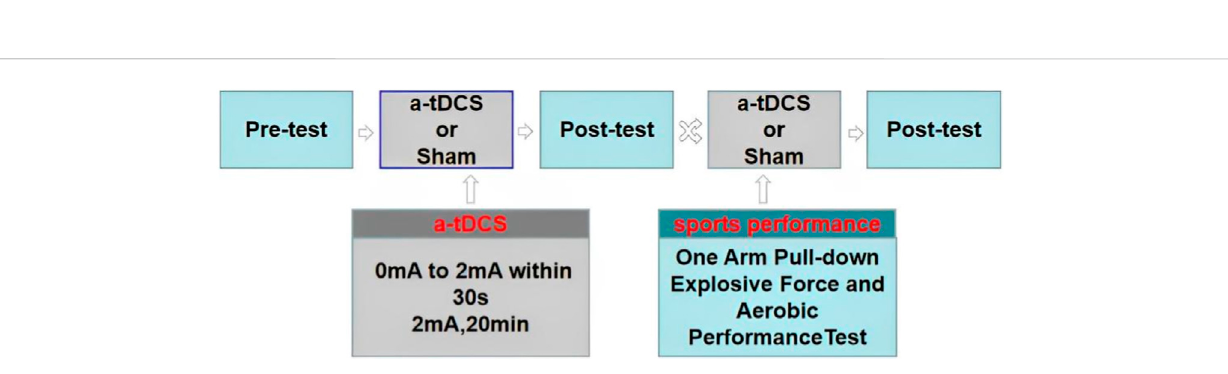
FIGURE 2 Study design. Pre-test and post-test indicate sports performance test, a-tDCS represents current gradually increasing from 0 mA to 2 mA within 30 s, and the whole test lasted for 20 min.